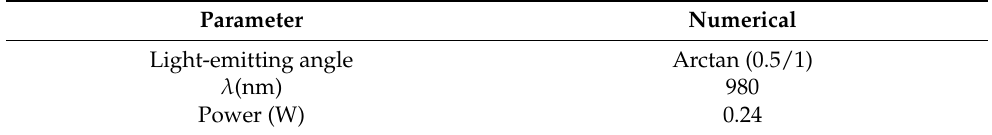
Table 1. Parameters of the light source.